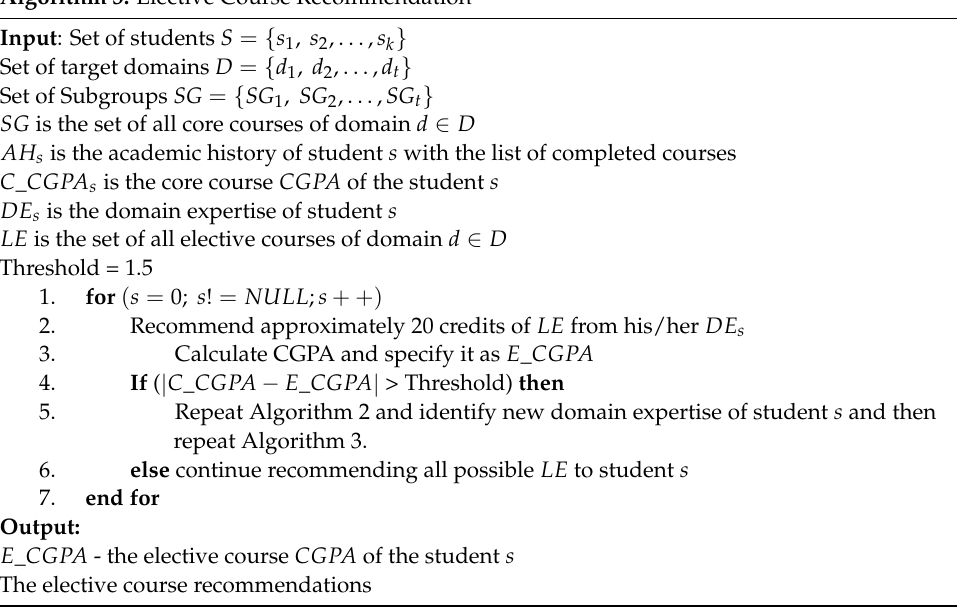
Algorithm 3: Elective Course